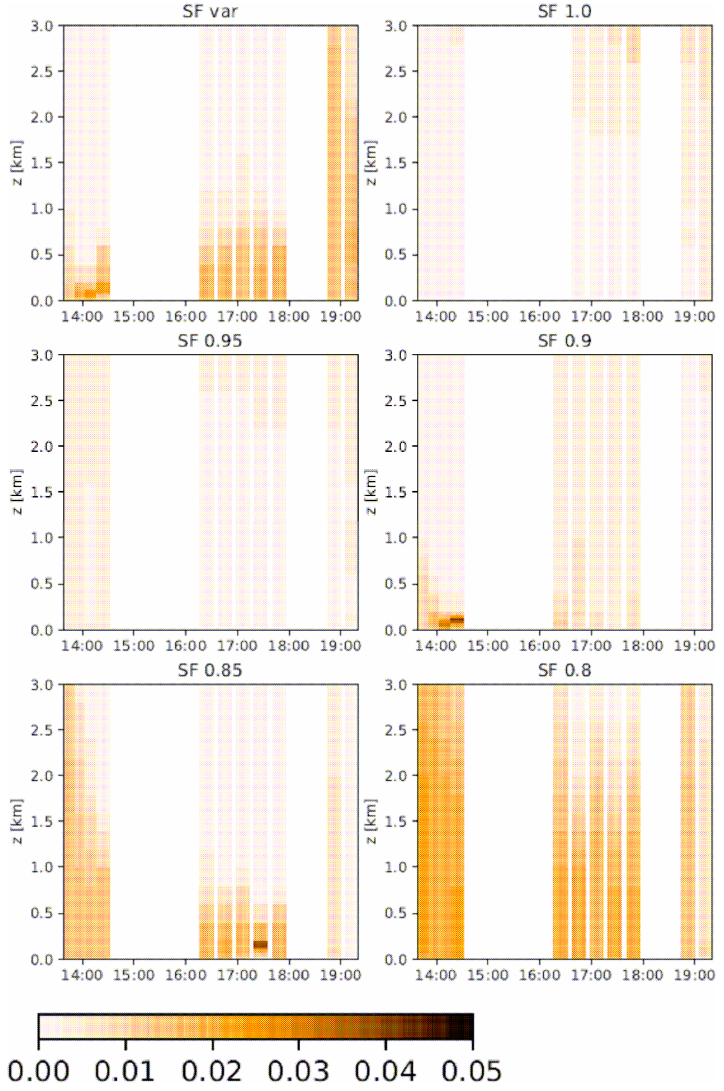
Figure A14. Extinction profiles retrieved with MAPA for the selected elevation sequences for different scaling factors. Only profiles for inversions with “valid” or “warning” flags are